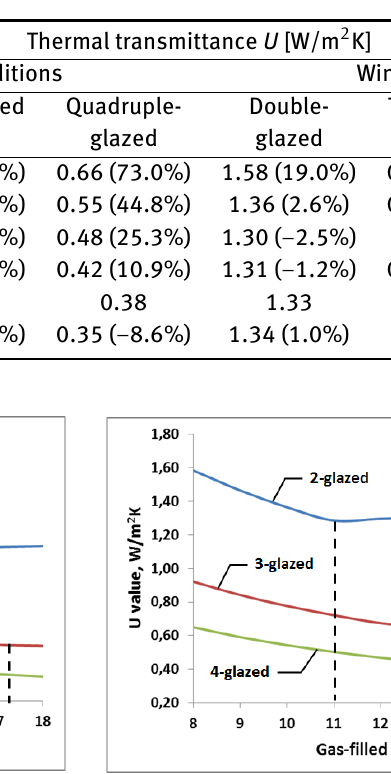
Figure 3: Dependence of thermal transmittance on gas-filled gap thickness for conditions: t e = 0 ∘ C, t i = 20 ∘ C.